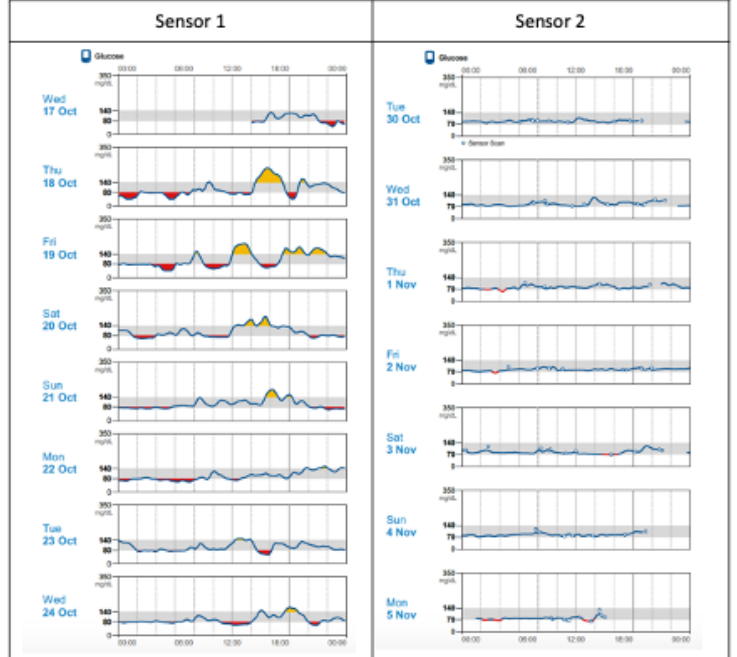
Figure 4. Comparison of daily glucose trends captured by Abbott continuous glucose monitor for one participant from both sensor periods of the